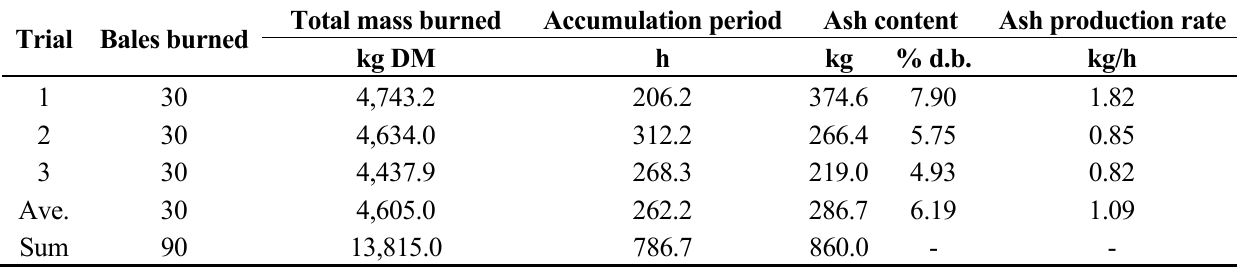
Table 7. Ash content and production rate for CS (2013